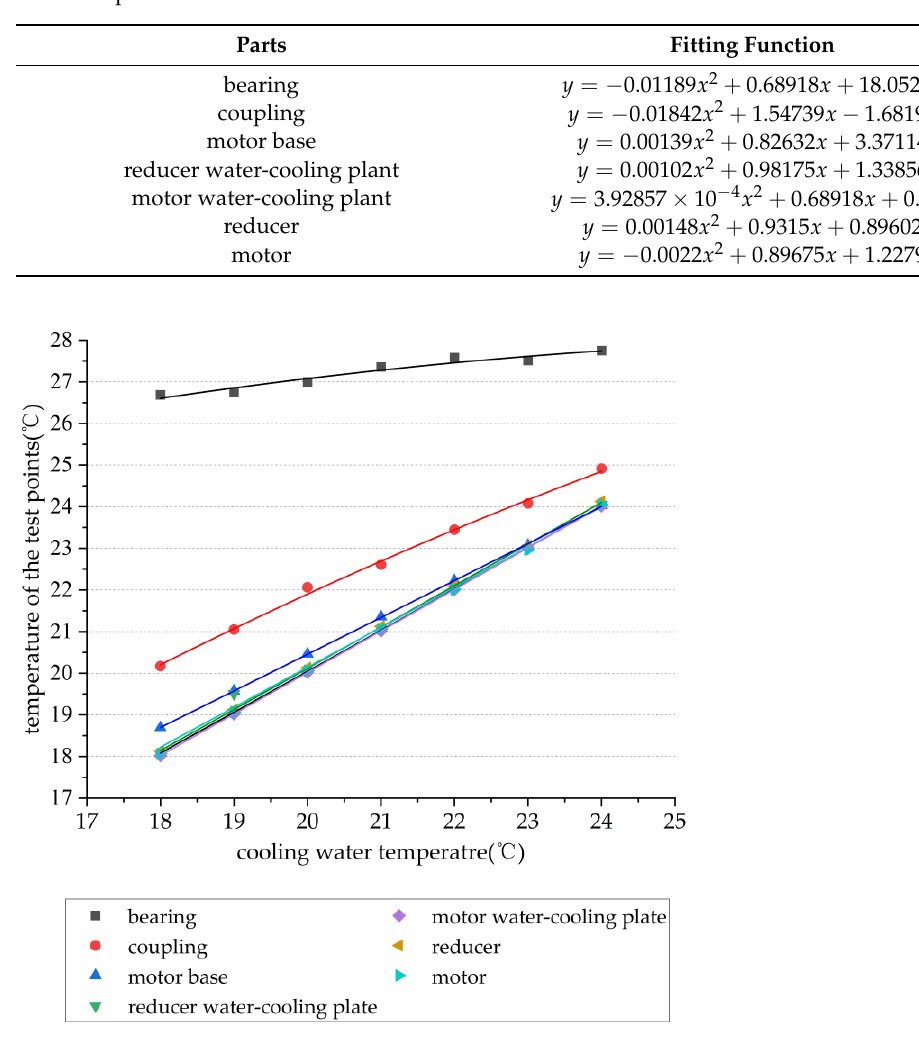
Figure 19. The effect of different water temperatures on the temperature of test points.